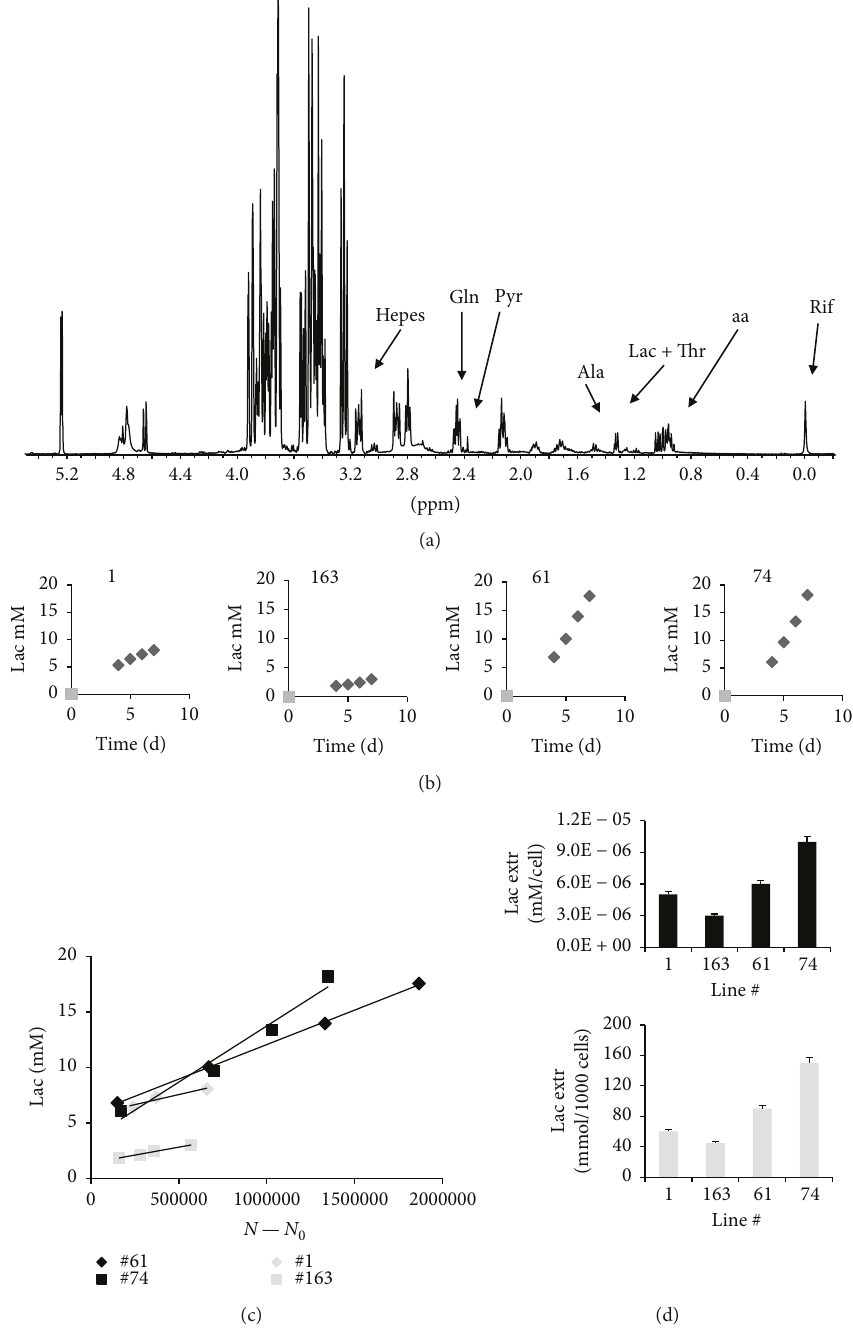
Figure 4: Lactate is di ff erently extruded by di ff erent GSCs. (a) MR spectrum of culture medium for line #163, at day 4 after seeding; (b) behavior of Lac signal intensity as a function of time, starting at day 4 after seeding; (c) excreted lactate from the selected GSC lines as a function of the number of cells ( N − N , where N is the number of seeded cells); the goodness of the linear fi t, R 2 , is in the range 0.96 – 0.99 for 0 0 all the lines. (d) reports the rate of lactate extrusion (mM/cells) and mmoles of lactate for 1000 cells, respectively, for all four lines. Deconvolution of Lac signal regions is reported in Figure